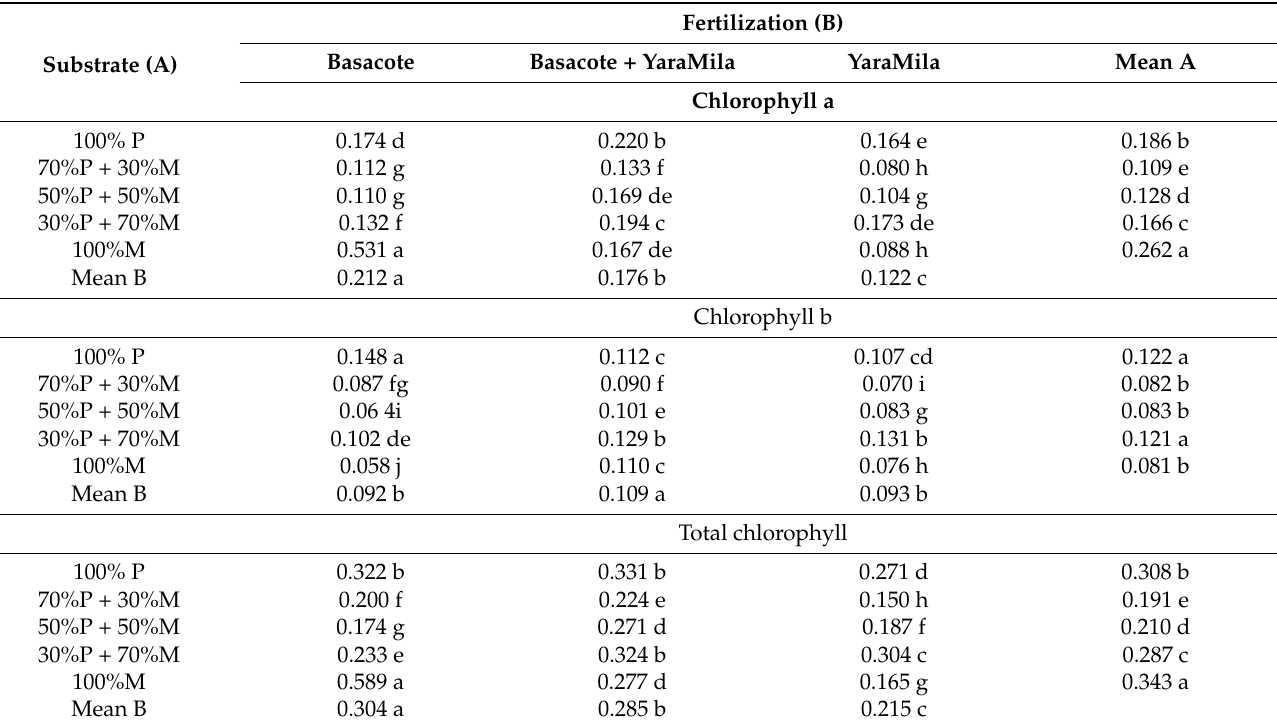
Table 8. Chlorophyll contents (mg/g) in leaves of Sedum spectabile ‘Stardust’ grown in containers with five different